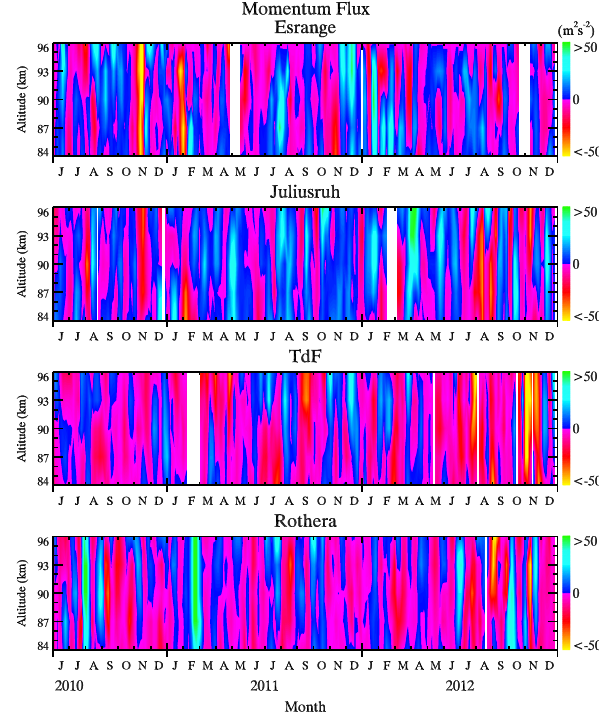
Figure 2. 5-day mean variances of the 5DW as a function of altitude between 84 and 96km over Esrange, Juliusruh, Tierra del Fuego, and Rothera from top to bottom.